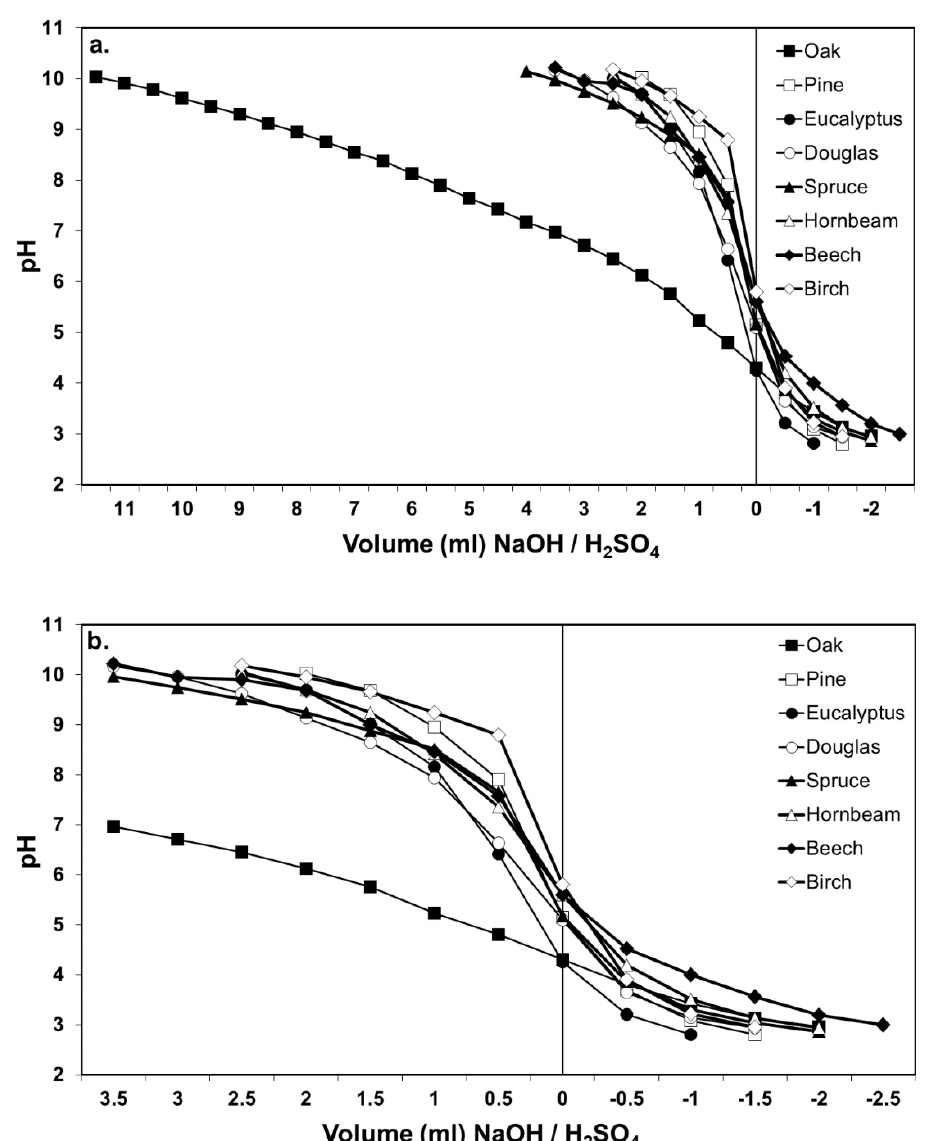
Figure 1. pH variation as a function of volume of 0.05N NaOH and / or 0.05 H 2 SO 4 titration solution: ( a ) all wood species reported; ( b ) expanded detail of the lower part of the curves.